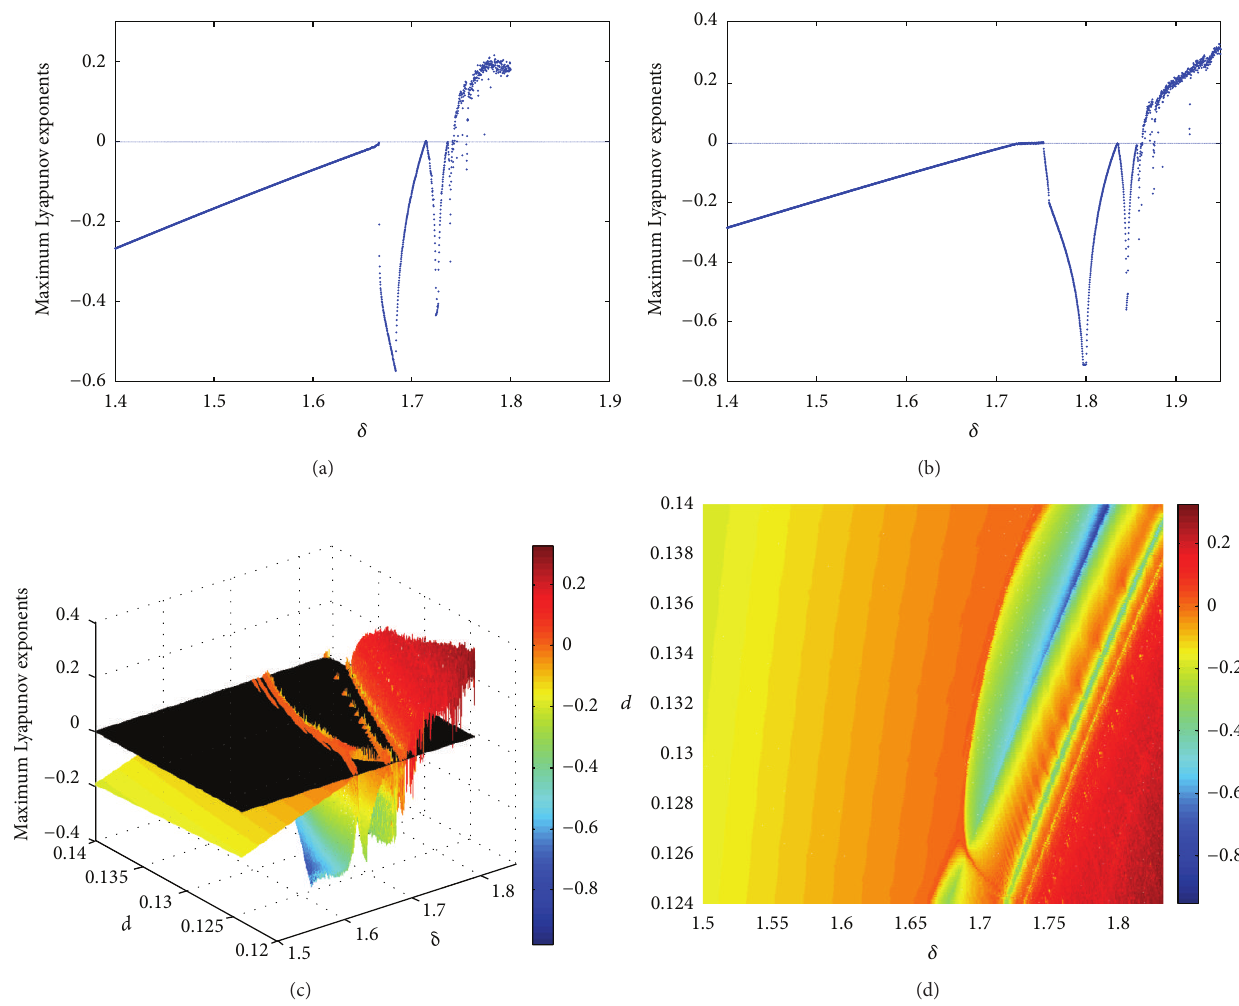
Figure 2: Maximum Lyapunov exponents of map (3) near 1: 3 resonance 𝐸 as 𝛿 and 𝑑 vary. (a) and (b) are maximum Lyapunov exponents corresponding to (a) and (b) in Figure 1. (c) and (d) are 3-dimensional maximum Lyapunov exponents in [1.5, 1.82] × [0.124, 0.14] and 2-dimensional projection onto (𝛿,𝑑)